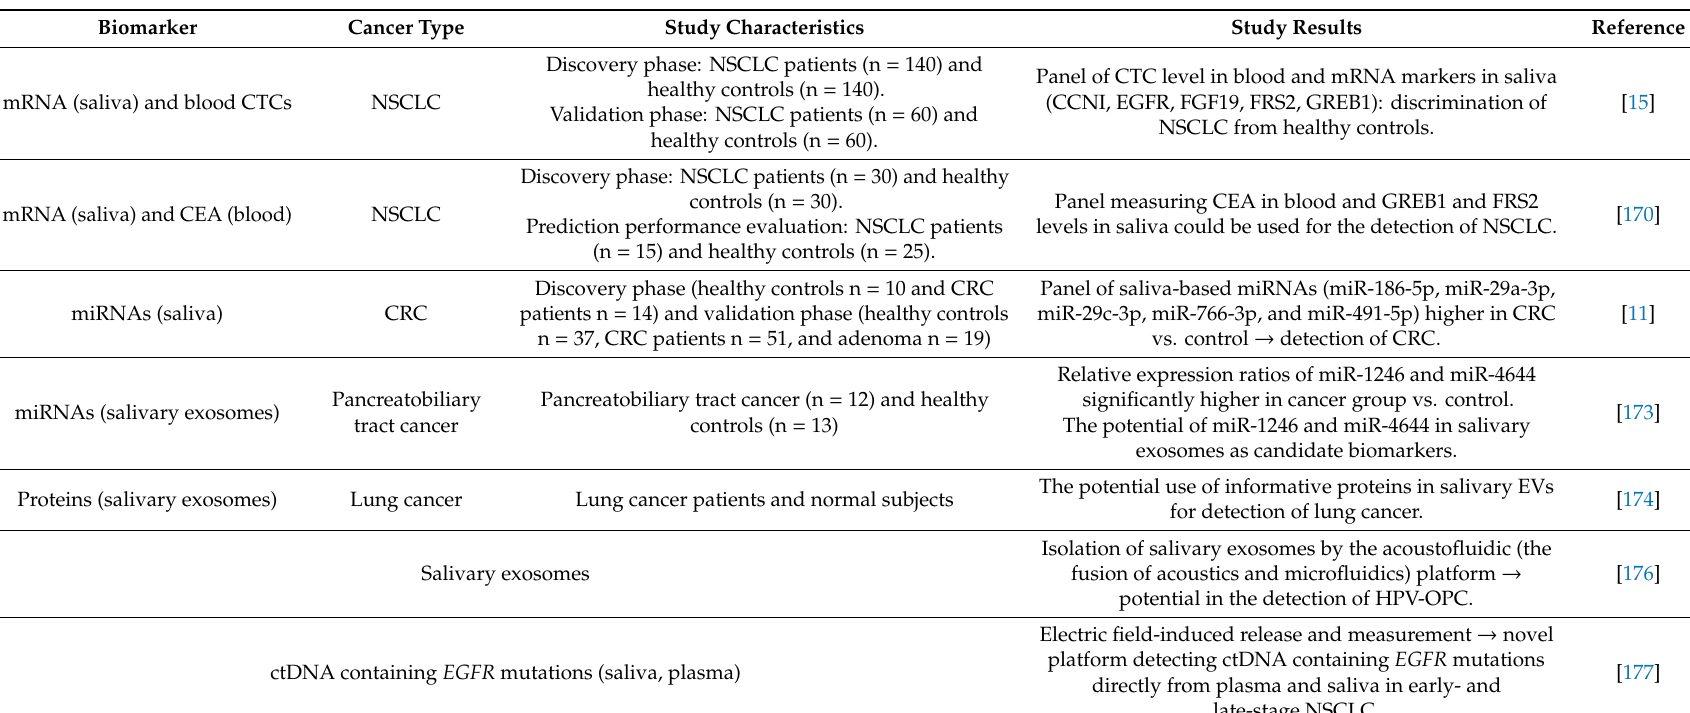
Table 4. Cancer biomarkers currently evaluated by saliva-based liquid